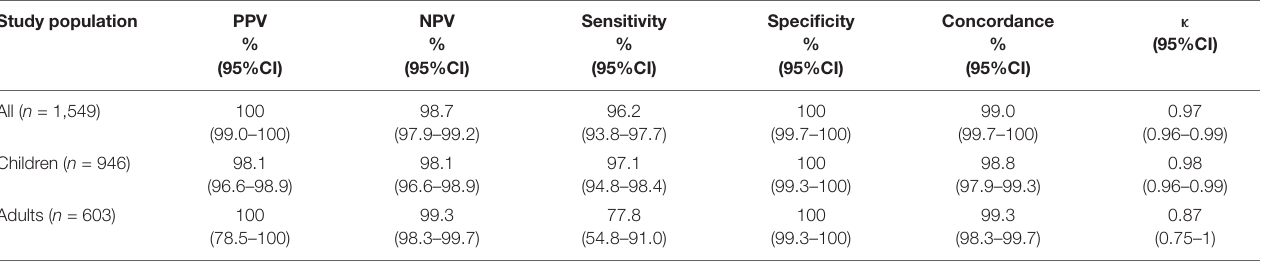
TABLE 5 | The accuracy of Streptococcus pneumoniae serotype detection in n = 1,549 nasopharyngeal samples from children ( n = 946) and adults ( n = 603) tested using molecular methods applied to DNA extracted culture-enriched samples. Study